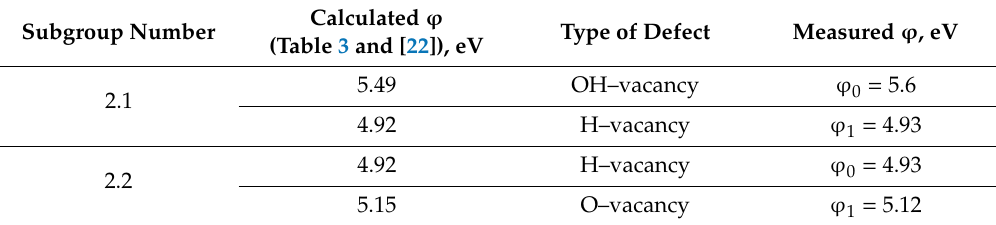
Table 9. Subgrouping of the samples of the group 2.